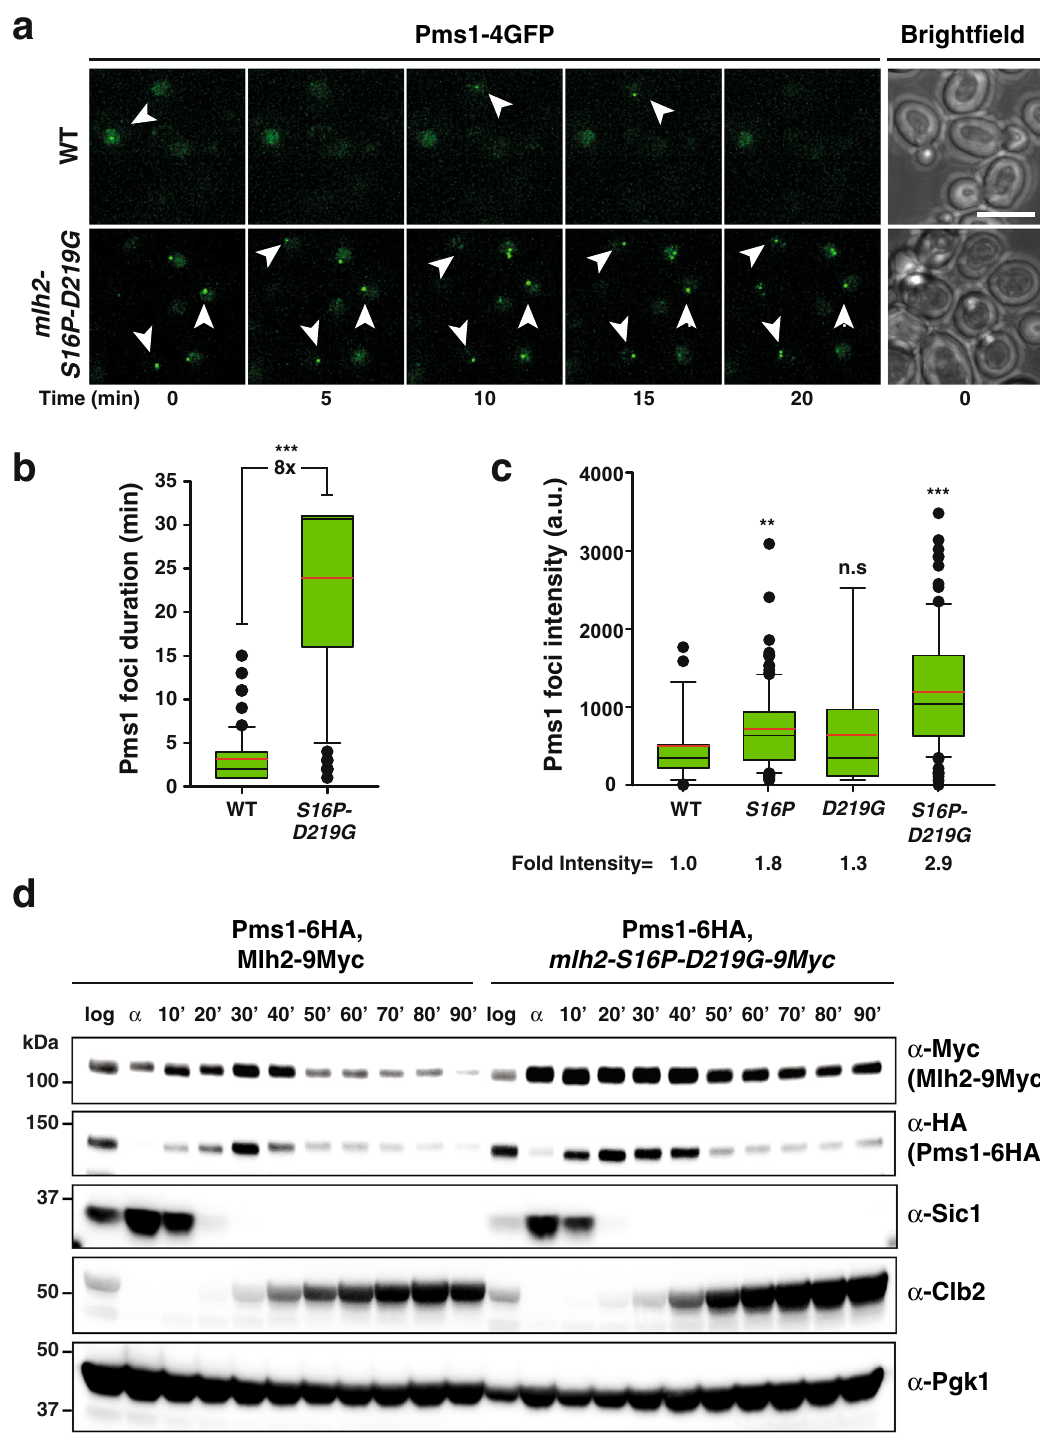
Fig. 3 MLH2 mutations result in abundant and persistent Pms1-4GFP foci, and altered Pms1 and Mlh2 expression pattern. a Representative time-lapse images following Pms1-4GFP foci in the WT and mlh2-S16P-D219G double mutant strain, over a 20 min period. Images were captured every minute. Arrowheads follow a focus in time; bar represent 5 μ m. Bright fi eld images were taken at the beginning of the time-lapse. b Quanti fi cation of Pms1 focus duration in the WT and mlh2-S16P-D219G double mutant. c Intensity of Pms1 foci was calculated in strains with indicated mlh2 mutation. Fold intensity shows the fold increase of the foci intensity (averaged value) of the mlh2 mutants compared with the WT. In b and c , the data are presented as box plots with whiskers, in which the black and red lines indicate the mean and the average, respectively. Black dots represent outliers. d Pms1 and Mlh2 protein expression in the WT and mlh2-S16P-D219G double mutant strains analyzed by Western blot. Lysates were prepared with α -factor synchronized cells that were released at different time points, as indicated. Data are representative of two independent experiments, which gave similar results. Sic1 and Clb2 were used as G1- and G2/M-phase markers, respectively. Pgk1 was used as a loading control. *** p < 0.001; ** p < 0.01; n.s indicates not signi fi cant compared to